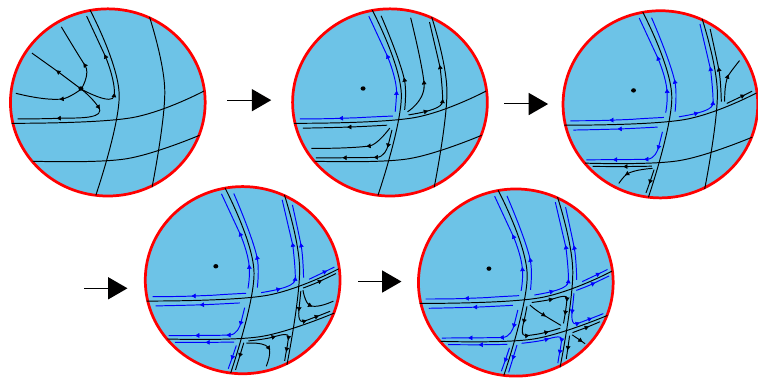
Figure 5 . We evolve a set of oriented Cauchy slices (black) through the disk. In this way, an orientation is associated to each of the boundaries of the smaller disks (blue) that allows for an SL + (2 , R ) BF calculation in each of these disks. The black dot represents the